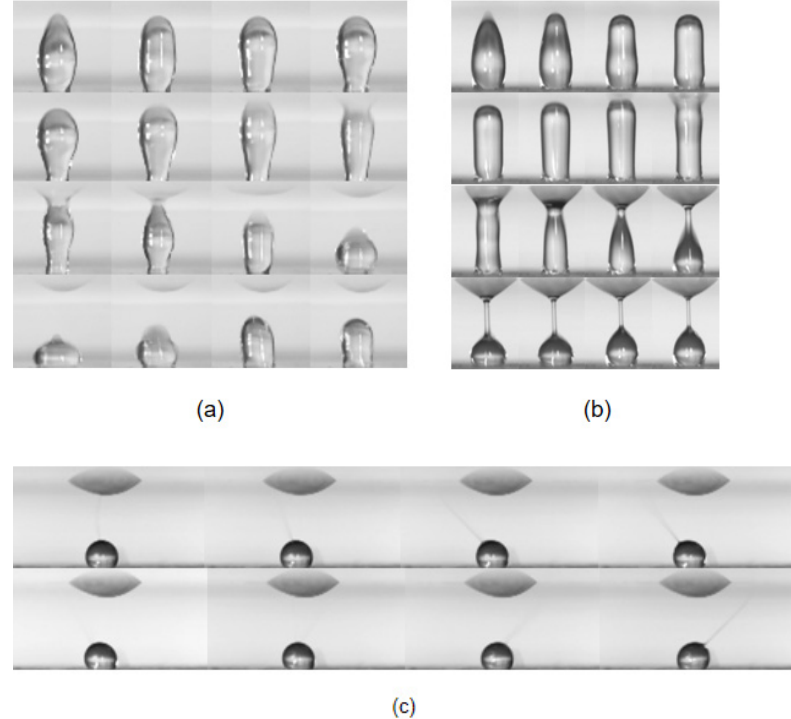
Figure 6. The liquid bridge phenomenon at a contact angle of 130 ◦ . ( a ) After the water contacts the top acrylic plate, a liquid bridge is formed for a short time, and then disappears; ( b ) PEO aqueous solution produced obvious liquid filaments after contacting the top acrylic plate; and ( c ) a phenomenon similar to electrospinning appears after the liquid filaments becomes thinner.